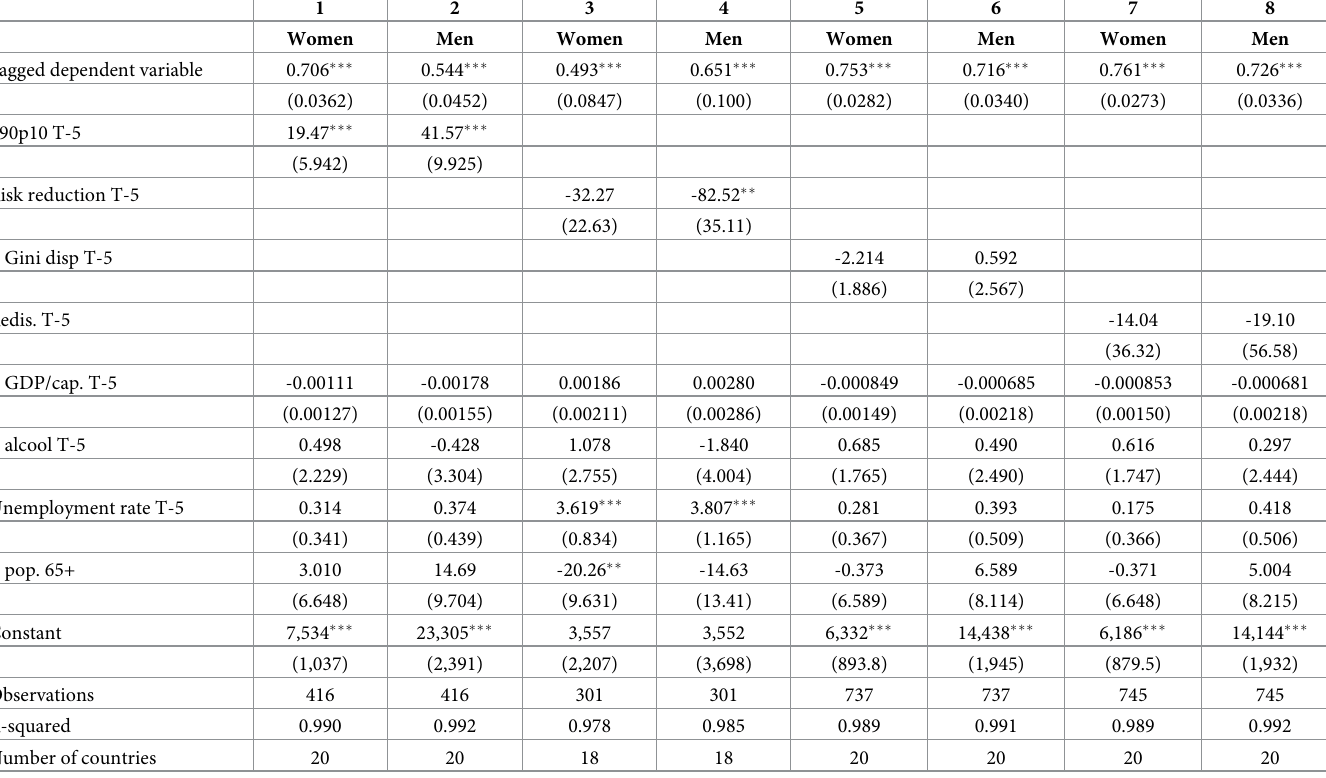
Table 2. Relationships between disposable income inequality, income redistribution, labour market polarization and risk reduction and the age-standardized death rate, with country fixed effects and country specific time